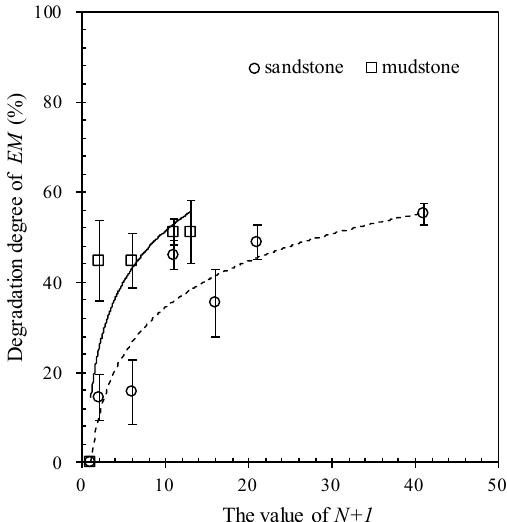
Figure 11. Relationship between the degradation degree of the EM and the value of N + 1.